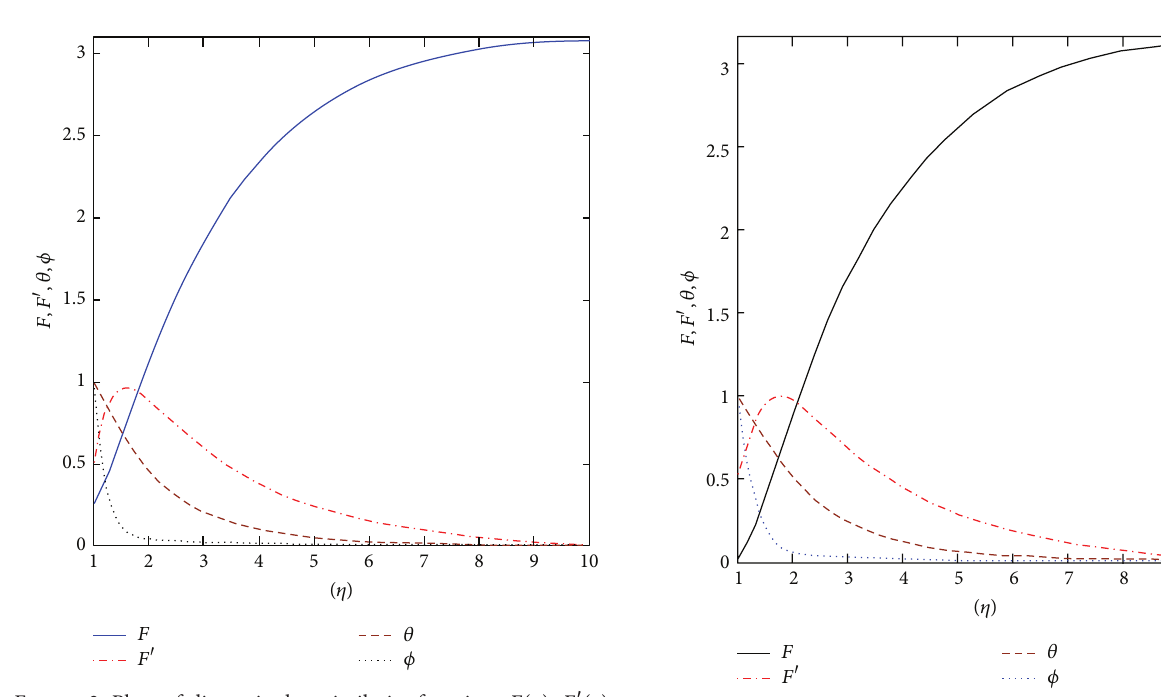
Figure 4: Plots of dimensionless similarity functions 𝐹(𝜂) , 𝐹 󸀠 (𝜂) , 𝜃(𝜂) , and 𝜙(𝜂) for the case of Le = 10, Nr = 0.5, Nb = 0.5, Nt = 0.5, and 𝜁 = 0 .